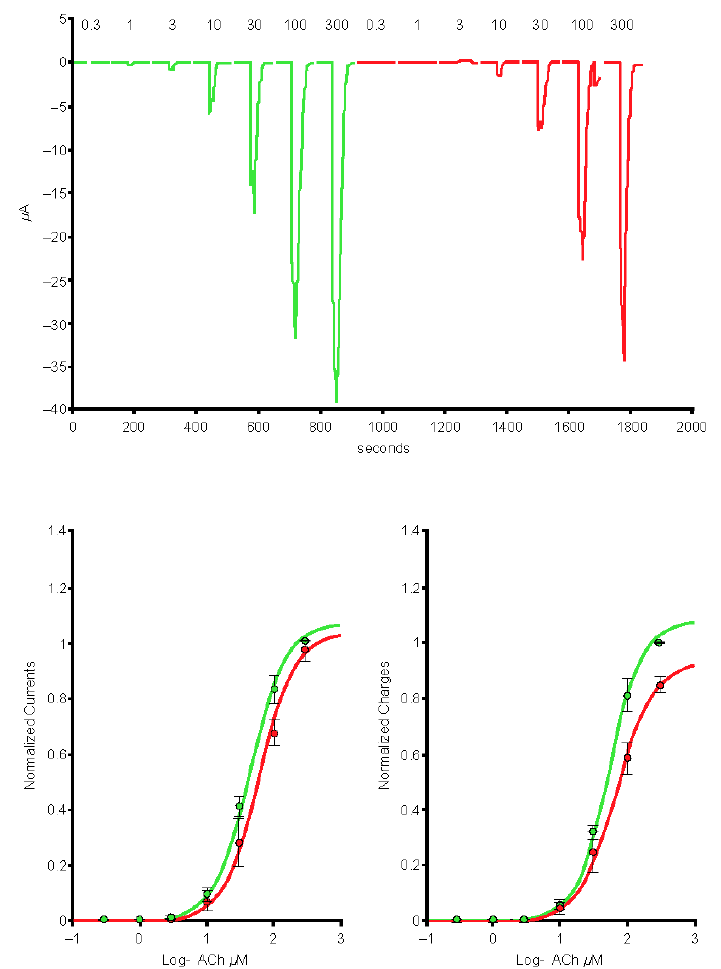
Figure 3. Effects of the spike protein containing the receptor-binding domain (Spike-RBD) protein at the concentration-response curve to acetylcholine (ACh) of the α 3 α 5 β 4 nicotinic acetylcholine receptor. Typical currents were recorded in the same cell before (green traces) and during exposure to 1 µg/mL of the Spike-RBD protein (red traces). Currents were elicited by brief exposure to ACh test pulses with a series of concentrations. Currents were normalized to unity vs. the maximal value and average results obtained in four cells were plotted vs. the logarithm (log) of the ACh concentration. The green curve is the best fit obtained with the Hill equation. Areas under the curve are plotted on the lower right-hand side.